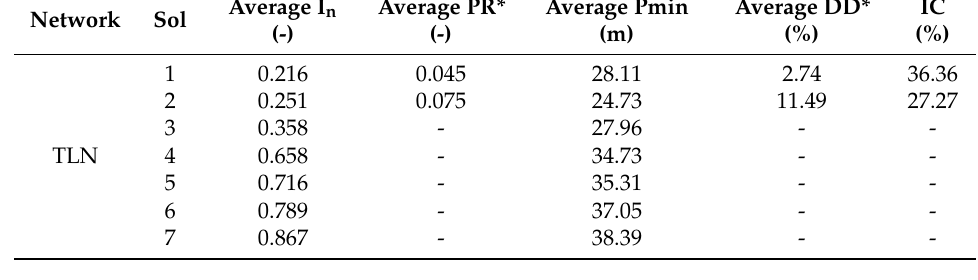
Table 9. Average characteristics of TLN solutions among all the scenarios.